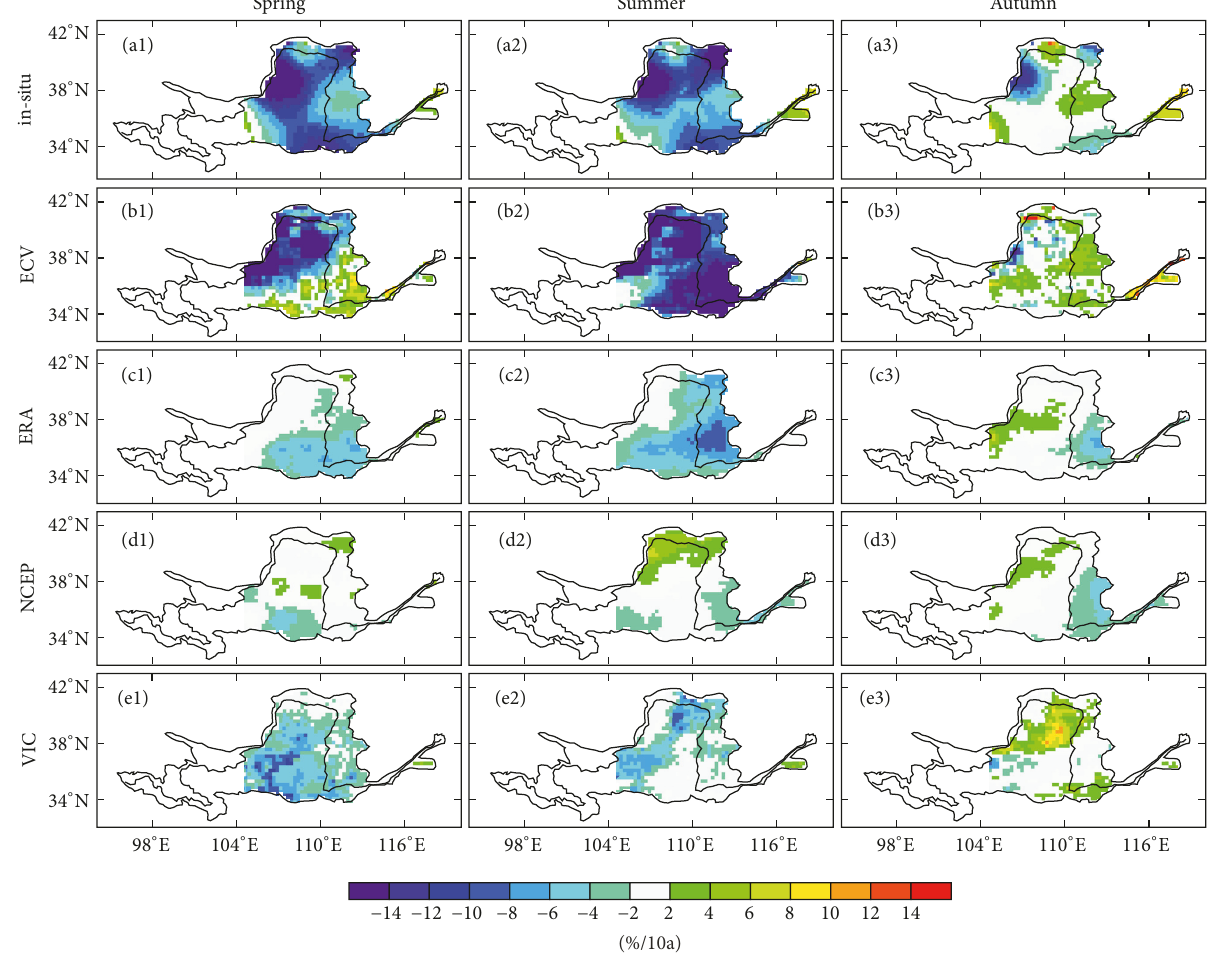
Figure 8: Pixel-wise linear trends of interannual variation for SM in situ , SM ECV , SM ERA , SM NCEP , and SM VIC data in spring, summer, and autumn, respectively, for the period of